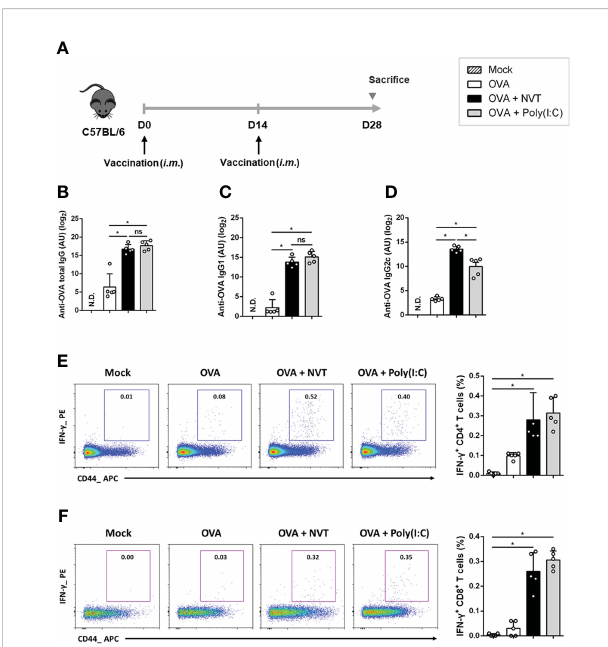
FIGURE 4 NVT potently enhances Th1-skewed antibody and T cell response. (A) C57BL/6 mice (n=5 per group) were primed and boosted via an intramuscular route with OVA (2 m g) either alone or adjuvanted with NVT (10 m g) or poly(I:C) (10 m g). (B-D) The levels of OVA-speci fi c total IgG, IgG1, and IgG2c antibodies in the serum were measured at 2 weeks post-boosting. (E, F) Spleen cells were obtained from mice 2 weeks after boosting and restimulated with OVA peptides (OVA 257-264 and OVA 323-339 ). After blocking cytokine secretion with protein transport inhibitor, surface staining was performed with anti-CD4, anti-CD8, and anti-CD44 antibodies, followed by intracellular staining with anti-IFN- g and anti-IL-4 antibodies. Flow cytometric analysis showed the proportion of IFN- g + -expressing CD4 and CD8 T cells in the draining iLN. Data are presented as the mean values ± S.D. *, P < 0.05; ns, not signi fi cant; N.D., not